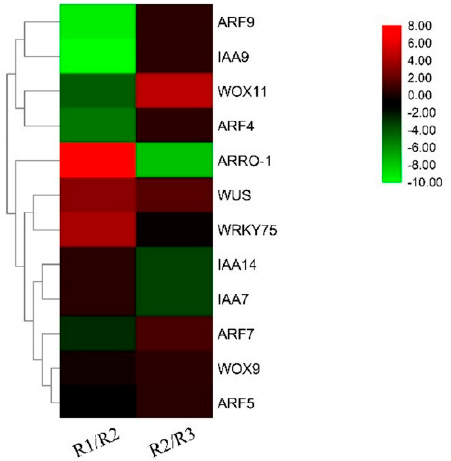
Figure 1. Root system − related genes in Paeonia suffruticosa root development under sandy soil cultivation (R1: root primordium ungerminated period; R2: root primordium induction period; R3: lateral root formation period).